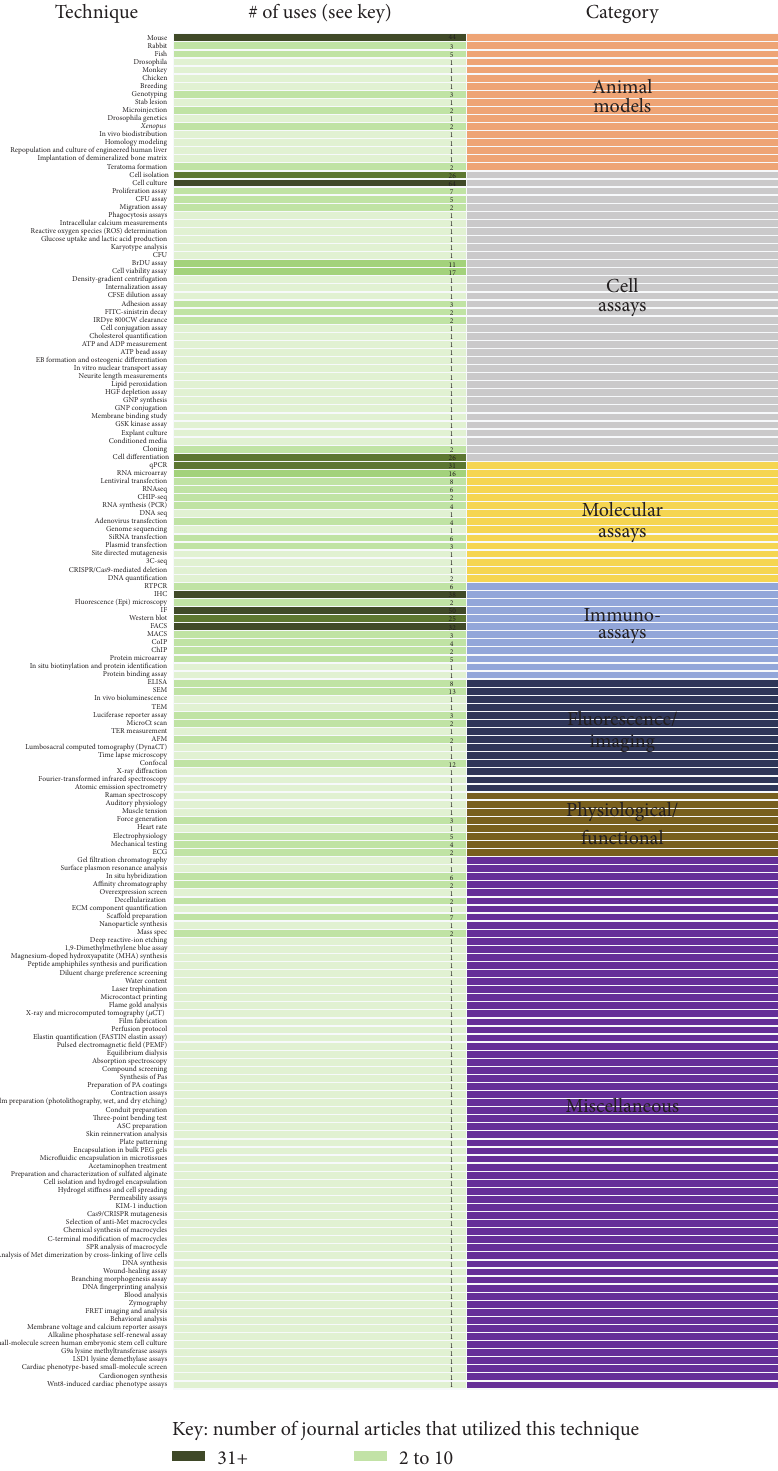
Figure 1: Compiled list of techniques used in regenerative medicine publications. A total of 887 data points were collected from a review of over 150 regenerative medicine articles which led to the identification of 169 distinct techniques. Techniques appeared in as many as 90 articlesandasfewas1article.Theidentifiedtechniqueswereorganizedinto7categoriesincludinganimalmodels,cellassays,molecularassays, immunoassays, fluorescence/imaging, and physiological/functional and miscellaneous. A comprehensive list of the techniques identified in this literature review is available in Supplemental